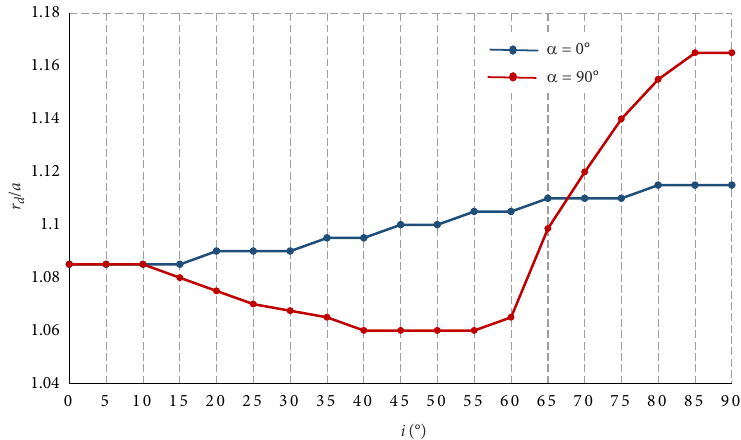
a = 0°: In this case, with the increase of the orienta- tion angle of the borehole, the depth of the breakout area gradually increases (blue curve, Figure 10), but the width of the breakout increases up to i = 30° and after that, it decreases at a very low rate (blue curve, Figure 11). An example of failure contour is shown in Figure 12a.